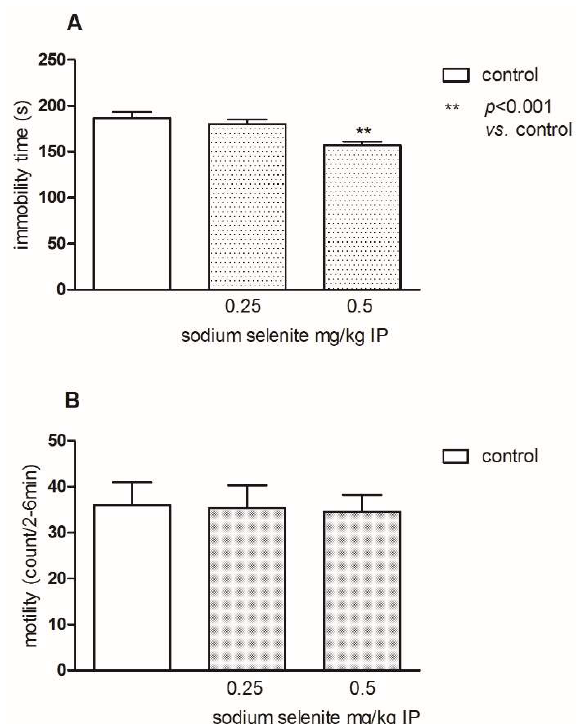
Figure 1. The effect of sodium selenite (at the doses 0.25 and 0.5 mg/kg) on the total duration of immobility in the forced swim test (FST) in mice ( A ) and on the spontaneous locomotor activity in mice ( B ). The values represent the mean of immobility time ± SEM (standard error of the mean) in the FST and the movement of mice between the 2nd and 6th min ± SEM in the locomotor activity test. Sodium selenite was injected intraperitoneally (IP) 30 min before the test. ** p < 0.01 vs. control vehicle-treated group (Bonferroni’s test).